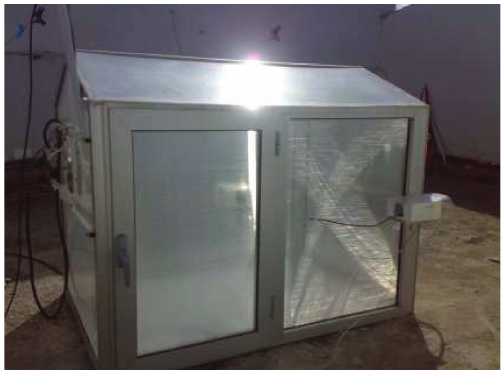
Figure 1: Greenhouse process.